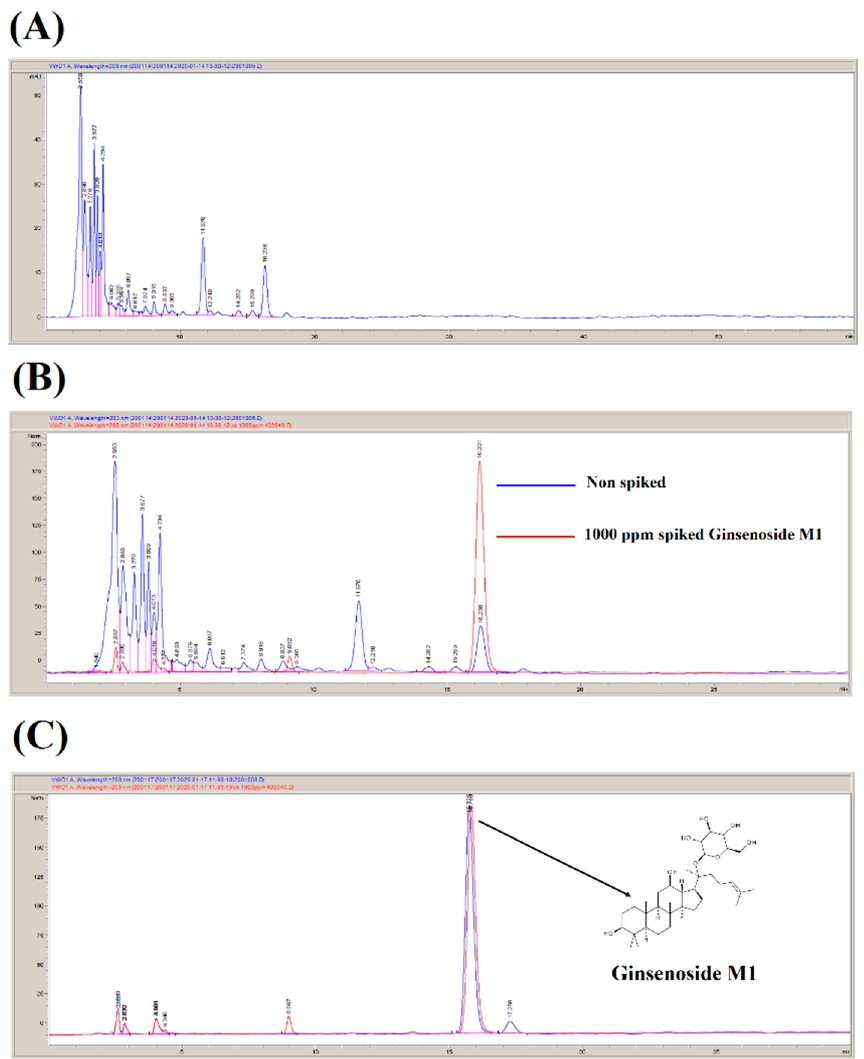
Figure 1. Biotransformation of ginsenoside M1. ( A ) HPLC analysis of Panax notoginseng leaves saponins extract. ( B ) HPLC analysis of ginsenoside M1-enriched extract after fungus SP-LSL-002 fermentation. ( C ) HPLC analysis of purified ginsenoside